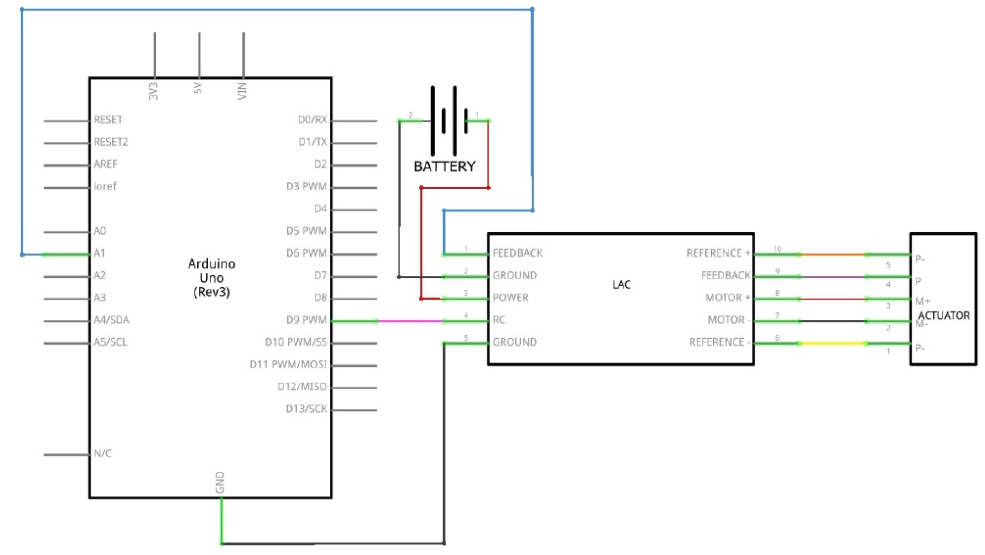
Figure 12. Arduino-LAC-motor circuit of the test bench.